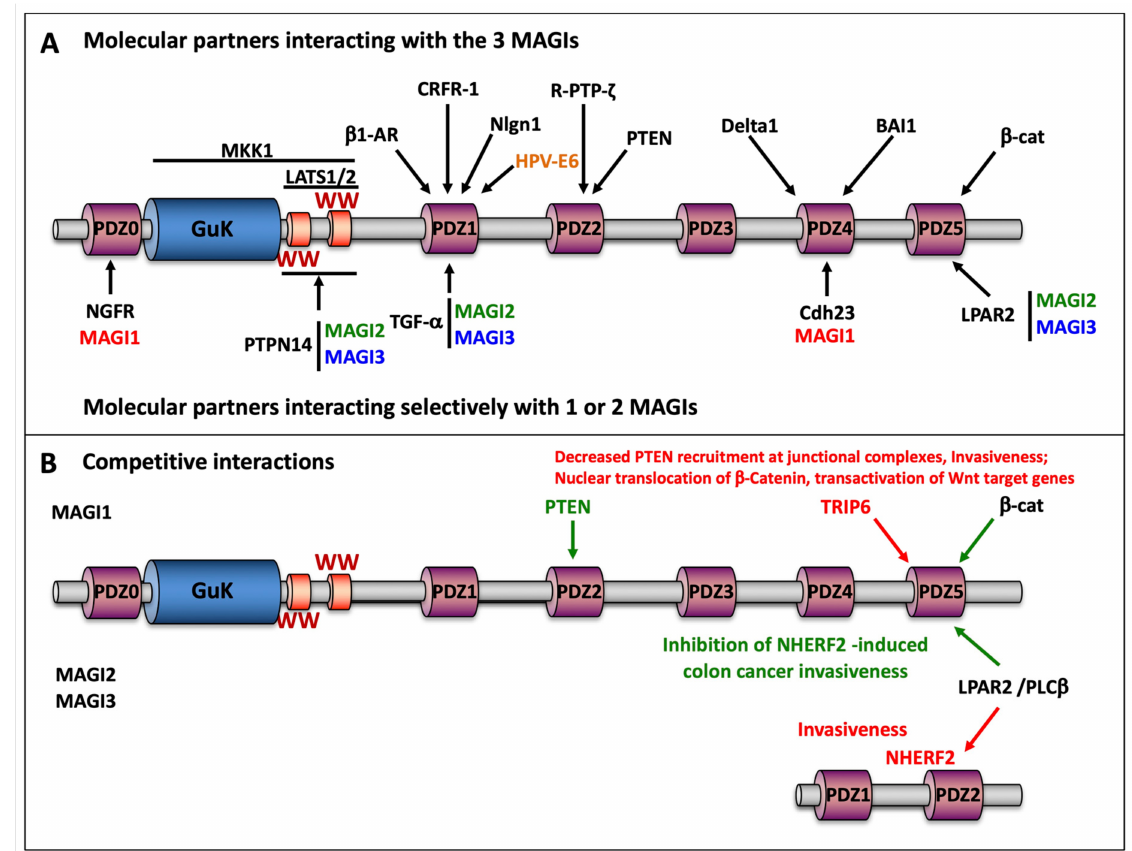
Figure 2. Molecular partners of MAGI scaffolding molecules. ( A ) The scheme displays the selective interaction of MAGIs with molecular partners that are either shared by these three scaffolding molecules or restricted to a subset. For easy viewing, MAGI1, 2, and 3 are displayed in red, green, and blue fonts, respectively. The cellular molecular partners are in black font and the viral oncoprotein E6 in orange font. ( B ) MAGIs can compete with other scaffolding molecules, e.g., NHERF2 to interact with the same molecular target (MAGI2, 3). Conversely, some molecular partners of MAGIs can compete for interacting with the same binding module, e.g., β –catenin vs. TRIP6 (MAGI1). These competitions trigger distinct signaling pathways and cell fate. The prooncogenic pathways are depicted in red, the tumor suppressor pathways in green. β 1-AR: beta-1 adrenergic receptor; BAI1: brain-specific angiogenesis inhibitor 1/ adhesion G protein-coupled receptor B1; Cdh23: cadherin 23; CRFR-1: corticotropin-releasing hormone receptor 1; β –cat: catenin beta-1; Delta1: delta-like protein 1; LATS1/2: large tumor suppressor homolog 1/2; LPAR2: lysophosphatidic acid receptor 2; MKK1: mitogen-activated protein kinase kinase 1; NGFR: low-affinity nerve growth factor receptor; NHERF2: Na(+)/H(+) exchange regulatory cofactor NHE-RF2; Nlgn1: Neuroligin-1; PLC β : 1- phosphatidylinositol 4,5-bisphosphate phosphodiesterase beta; PTEN: phosphatase and tensin homolog; PTPN14: protein tyrosine phosphatase non-receptor type 14; R-PTP- ζ : receptor-type tyrosine-protein phosphatase zeta; TGF- α : (pro)transforming growth factor-alpha; TRIP6: thyroid receptor-interacting protein 6; HPV-E6: protein E6 human